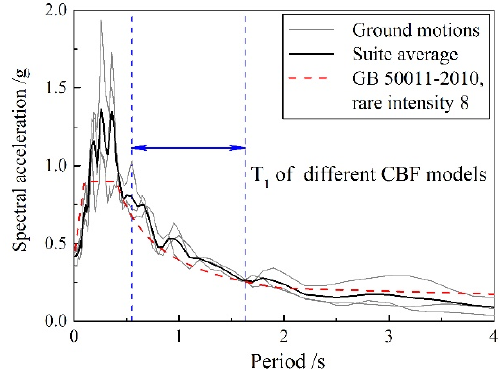
Figure 12. Ground-motion-suite response spectra.